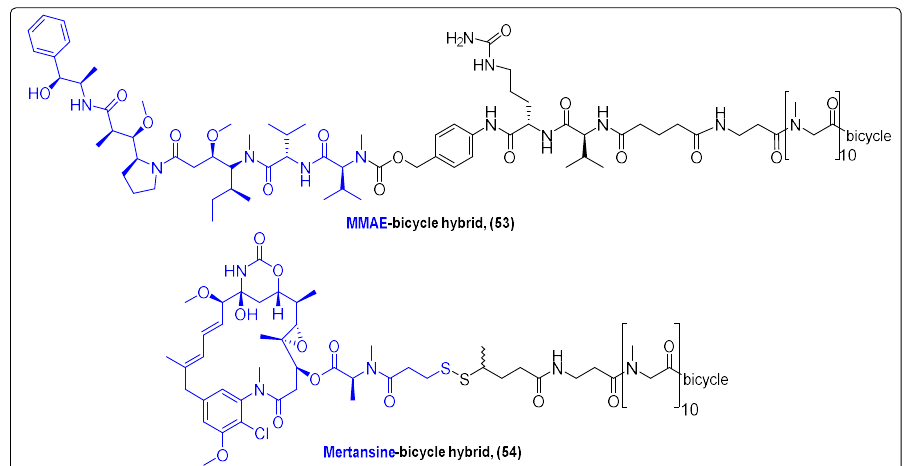
Figure 17. Peptide conjugates of MMAE and mertasine.